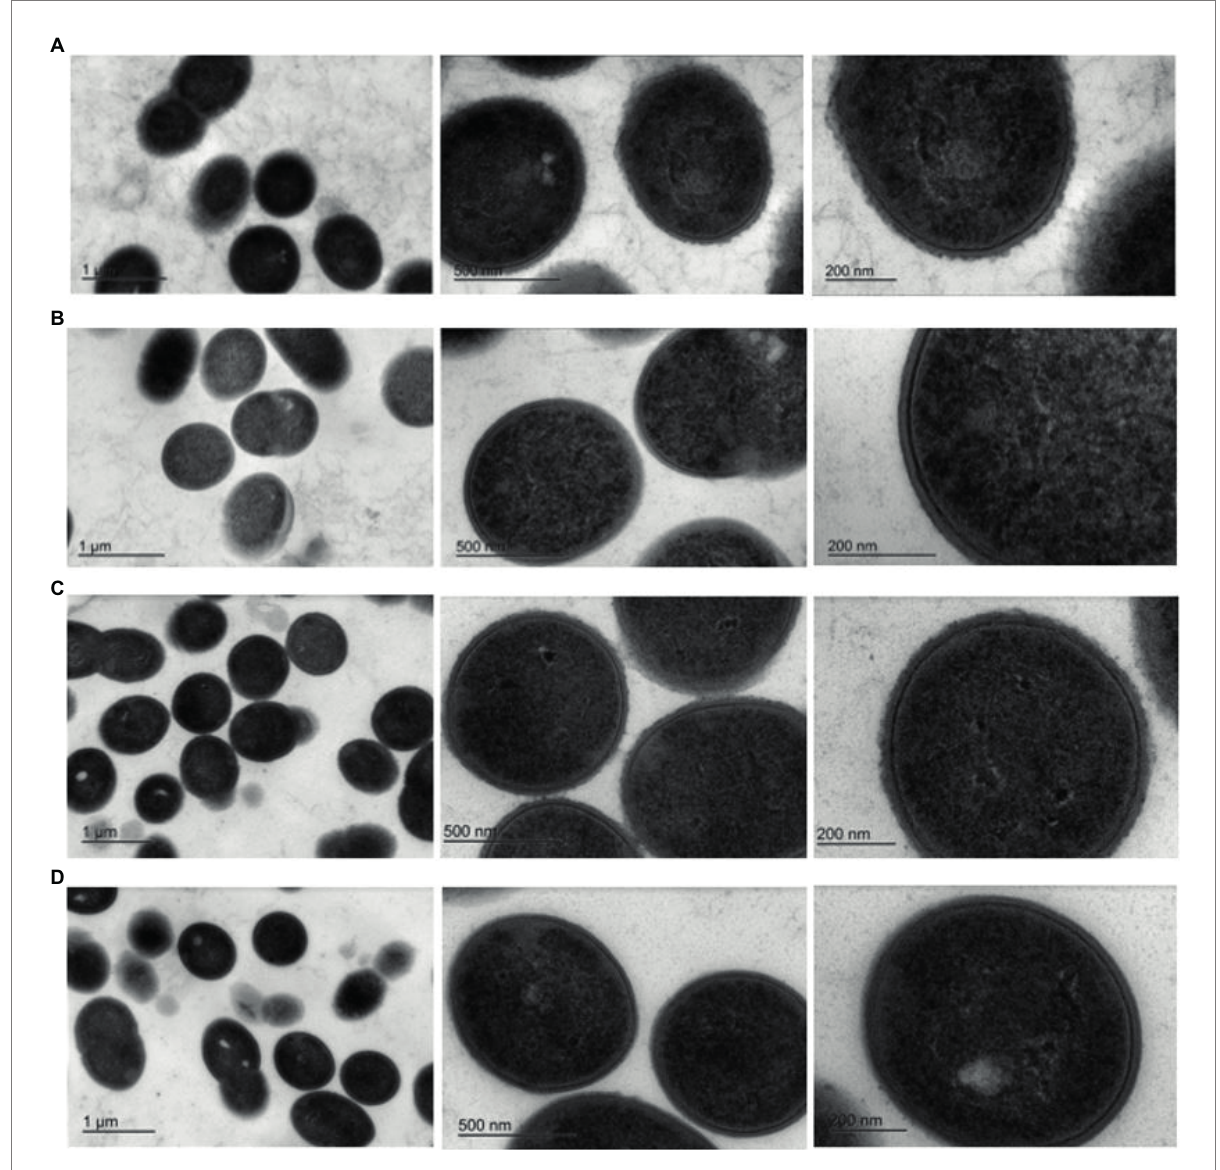
FIGURE 2 Transmission electron micrographs at three different magnifications. Row (A) . 6073-like EPS + strain DGCC6073; Row (B) . EPS - variant 6073A ∆ EPS; Row (C) . 7127-like EPS + strain DGCC7127; Row (D) . EPS - variant 7127 ∆